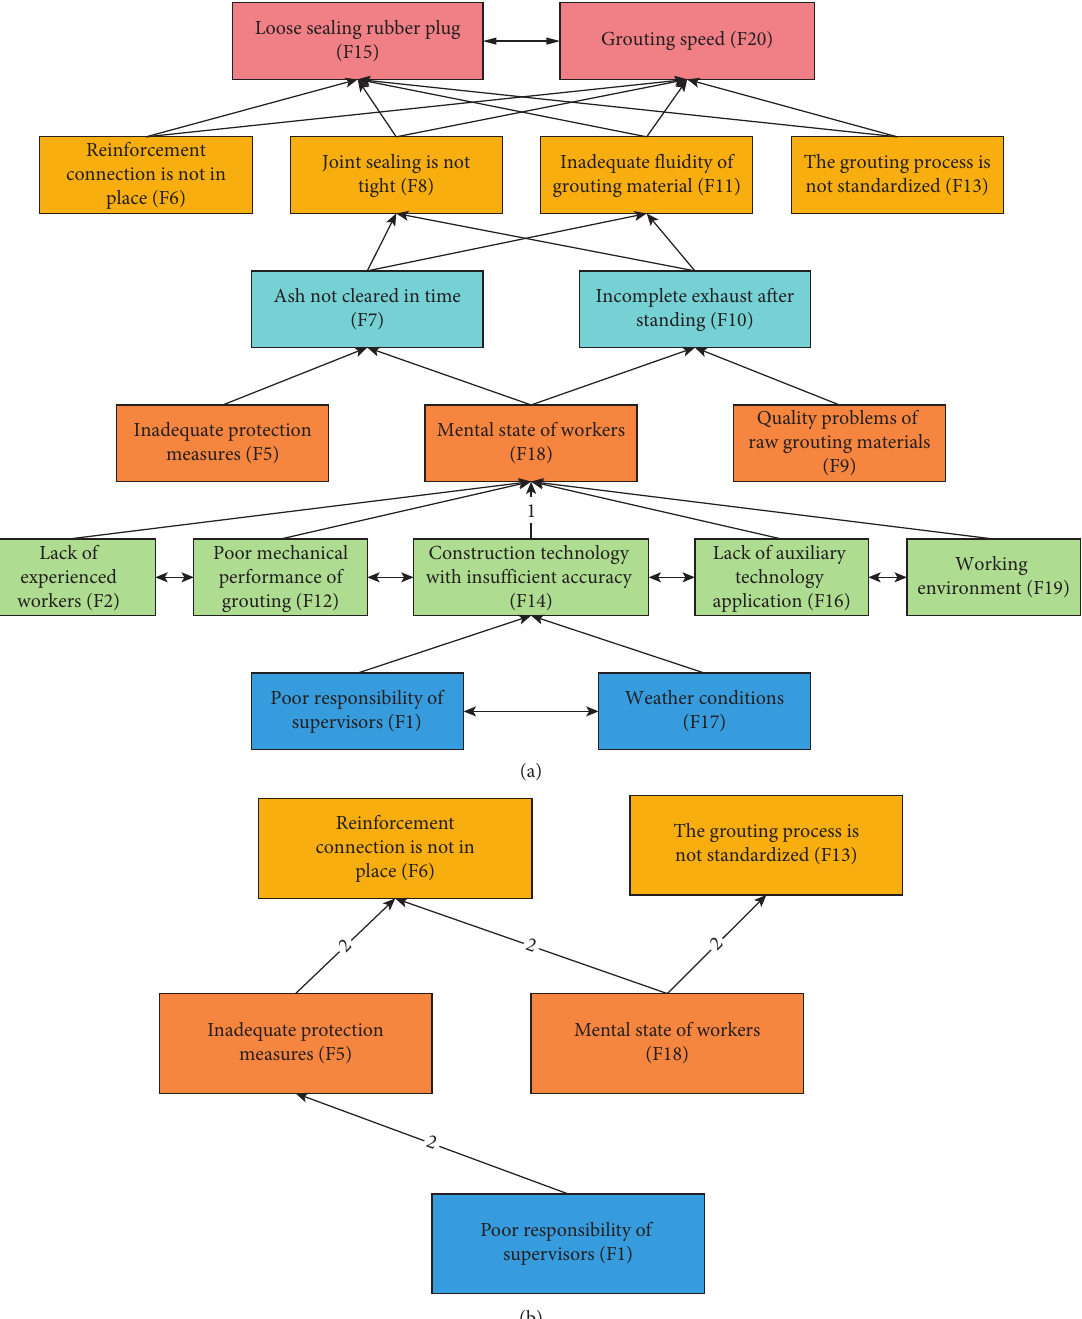
Figure 7: ISM model of factors: (a) first-level diagram; (b) cross-level